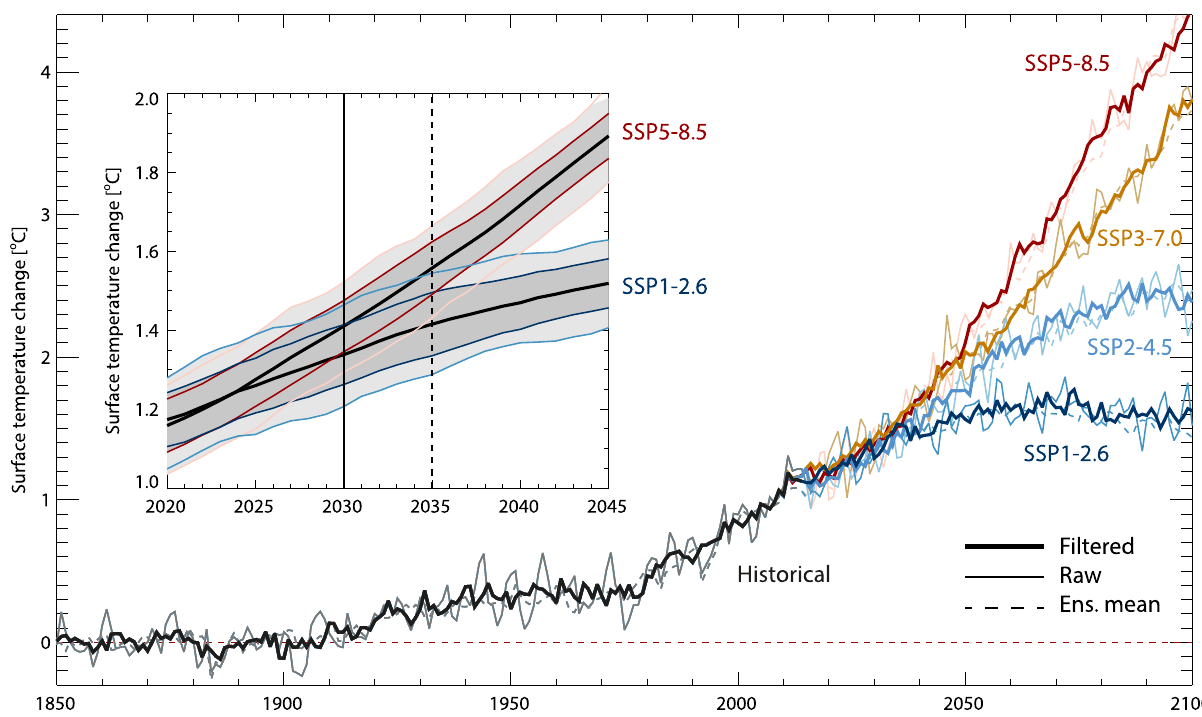
Fig. 3 Raw and fi ltered global mean surface temperature anomaly (GSTA) values from one ensemble member of the MPI-ESM1.2 Earth System Model. Emissions follow historical (black) and Shared Socioeconomic Pathway (SSP) scenario (colored) trajectories. Inset: Mean and ±1 standard deviation ranges for a 10-member initial condition ensemble from MPI-ESM1.2, for raw (light shading) and fi ltered (dark shading) GSTA values. Vertical lines show the year of emergence in the fi ltered (solid) and un fi ltered (dashed) case, based on 10-year running means. Table 1 Earlier emergence of a change in 10-year (left) and 20-year (right) smoothed GSTA in fi ltered simulations from MPI- ESM1.2, relative to un fi ltered simulations.